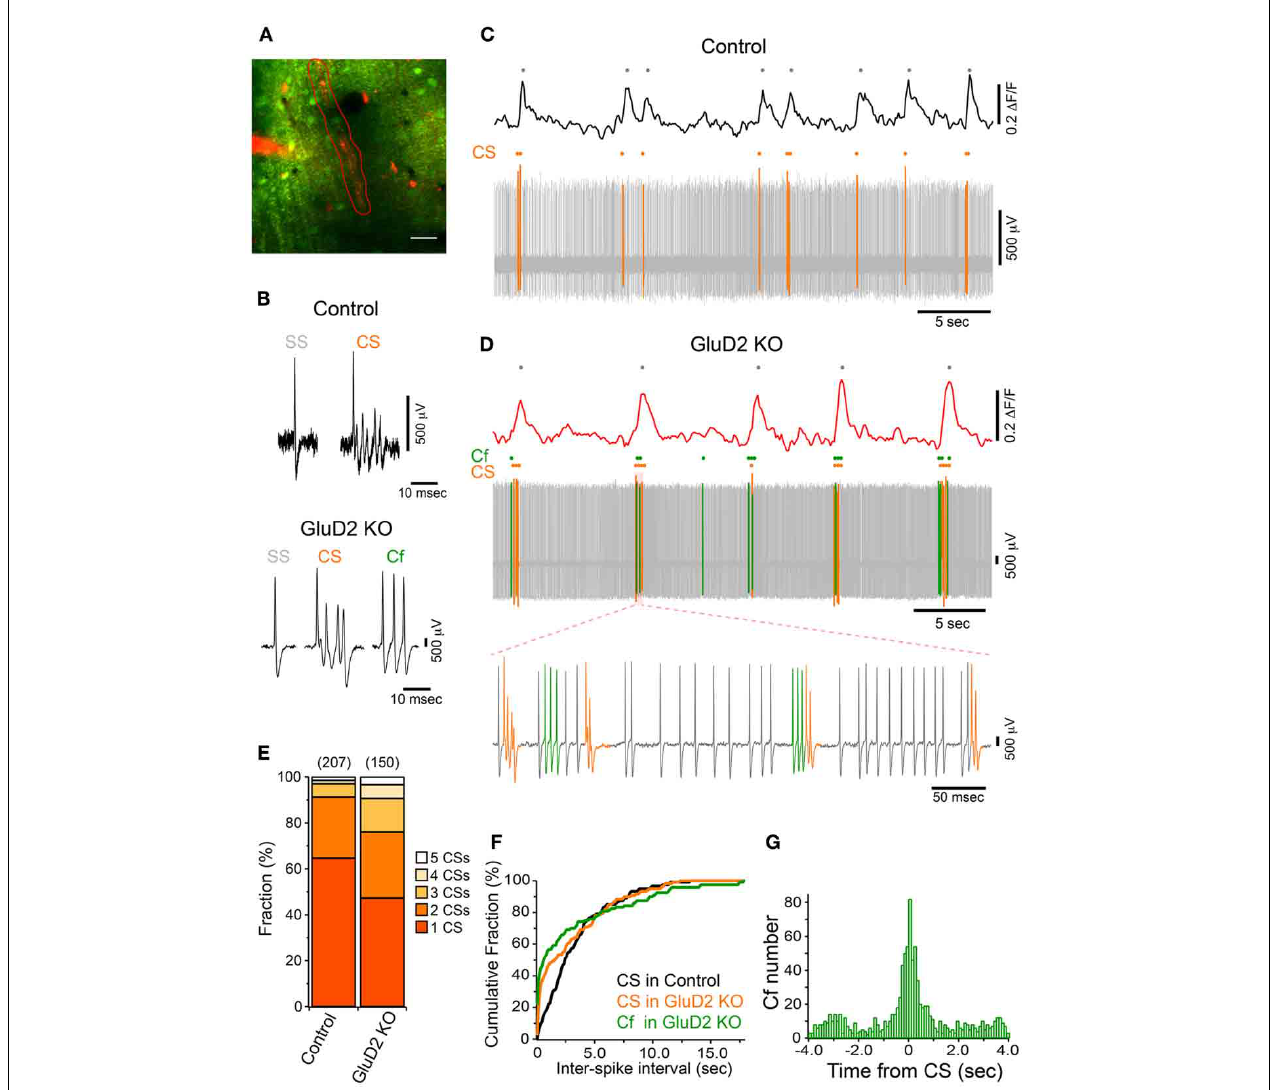
FIGURE 3 | Altered CF activity patterns in GluD2 KO mice. (A) Representative image showing the molecular layer that was loaded with OGB-1 AM in a GluD2 KO mouse. Simultaneous cell-attached recording and dendritic calcium imaging from single PCs were performed. After the recording, Alexa 594 was injected through the patch pipette to the PC from which cell-attached recording was conducted. Spontaneous calcium transients were obtained from the ROI enclosed by red line. Scale bar, 20 μ m. (B) Sample traces for simple spike (SS), complex spike (CS), and clustered firing (Cf) under cell-attached recordings from control (upper panel) and GluD2 KO (lower panel) mice. Cf was not observed in control mice. (C) Simultaneous recording of PC firing and dendritic calcium transients in a control PC. Note that all the calcium transients are associated with CSs. (D) Simultaneous recording of PC firing and dendritic calcium transients in the PC shown in (A) . SS, CS, and Cf are indicated in gray, orange, and green, respectively. Note that calcium transients are elicited only when CS occurs,